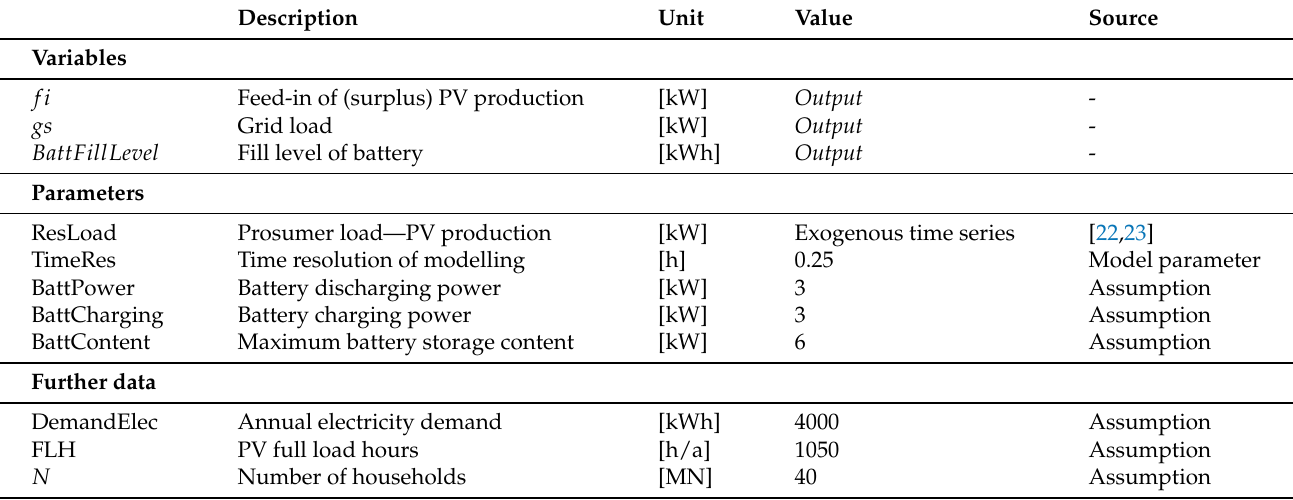
Table 1. Summary of the used variables and parameters for the prosumer battery storage